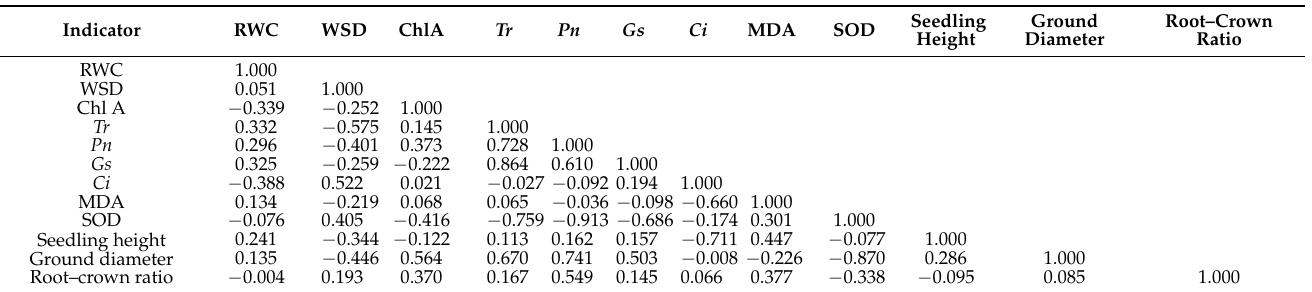
Table A7. Correlation analysis of the drought resistance coefficients of each index under severe drought stress.